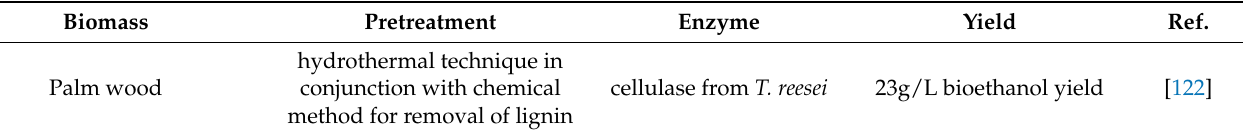
Table 3. Comparative chart for bioethanol production from wood